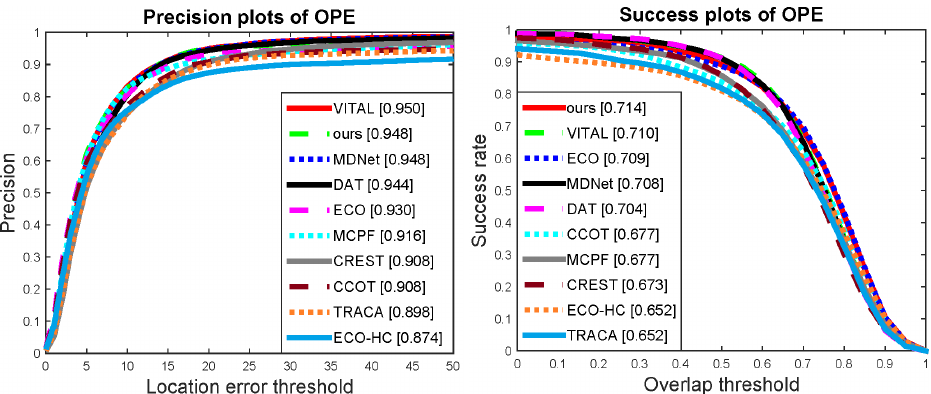
Figure 8. Precision plot and success plot on the OTB-2013 dataset. The AUV score and precision score of each tracker is shown in the legend. For clarity, we only show the top 10 trackers for performance. OTB-2015. The OTB-2015 dataset is based on the OTB-2013 dataset, which adds 50 additional sequences and is still fully annotated. We compared our approach with